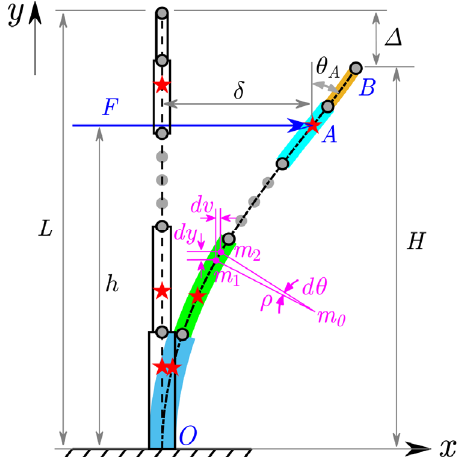
Figure 2. Bending diagram of tea stalk in large deflection. O , A , and B are the fixed point, load point, and free end on the deflection curve of the stalk, respectively. F is the load acting on the height h , and δ and θ A are the deflection and rotation angle at the point A , respectively. L is the length of the stalk, and Δ is the vertical displacement at the free end, and H is the appearance height of the stalk after deformation. The dashed line (--) and dash-dotted line (-.) are initial axial line and deflection curve of the stalk, and the circles ( ) and pentagrams ( ★ ) represent the actual nodes and virtual nodes, respectively.